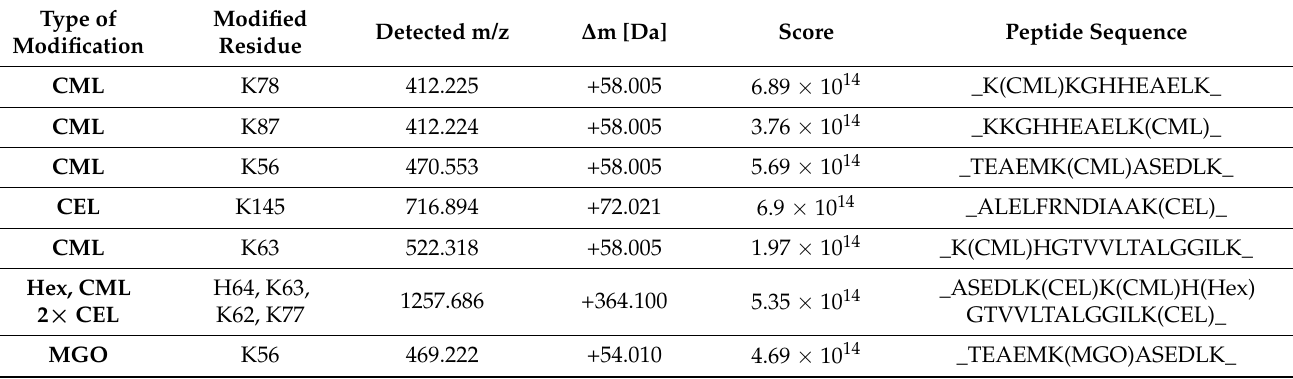
Table 1. Glycation adducts identified in native MB.